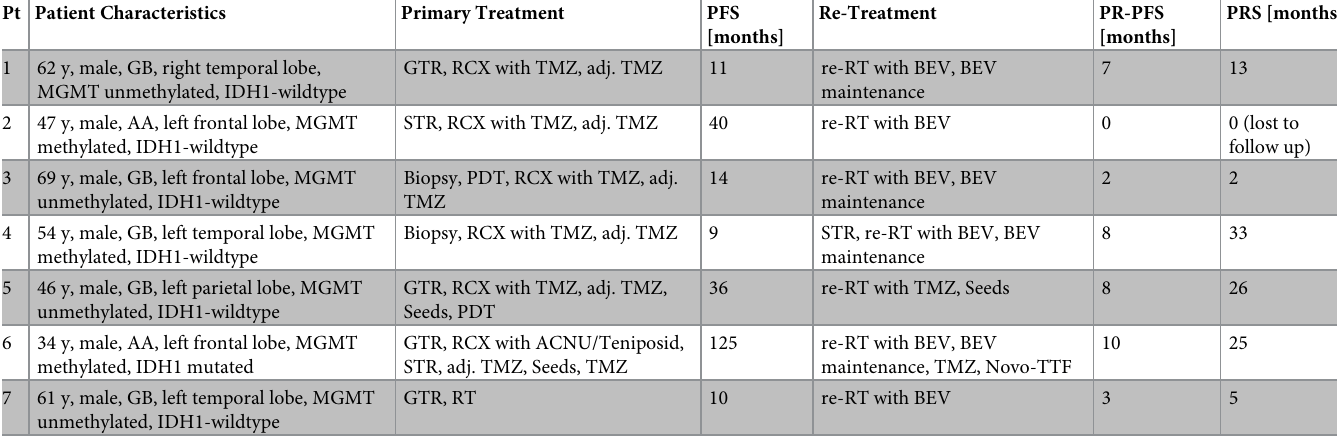
Table 1. Patient and treatment characteristics. Progression-free survival (PFS); re-treatment, post-recurrence survival (PRS) and post-recurrence progression-free sur- vival (PR-PFS); GB—glioblastoma, AA—anaplastic astrocytoma, GTR—gross total resection, STR—subtotal resection, RT—radiotherapy, RCX—radiochemotherapy, BEV—bevacizumab, TMZ—temozolomide, PDT—photodynamic therapy. Pt Patient